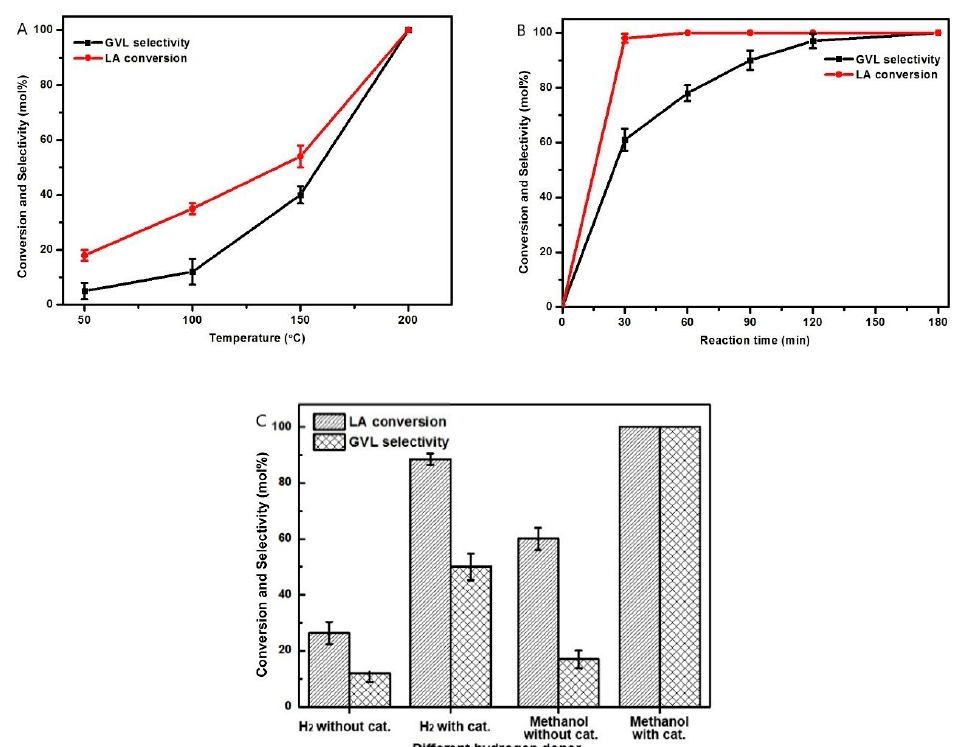
Figure 5. ( A ) The e ff ect of temperature (reaction conditions: 2 g LA, 15 mL MeOH, 0.5 g 5Ni-3Fe / SBA-15, 180 min), ( B ) reaction time (reaction conditions: 2 g LA, 15 mL methanol, 0.5 g 5Ni-3Fe / SBA-15, 200 ◦ C) and ( C ) di ff erent hydrogen sources (H 2 and MeOH) (reaction conditions: 2 g LA, 1 MPa H 2 or 15 mL MeOH, 0.5 g 5Ni-3Fe / SBA-15, 200 ◦ C, 180 min) on LA conversion and GVL selectivity.